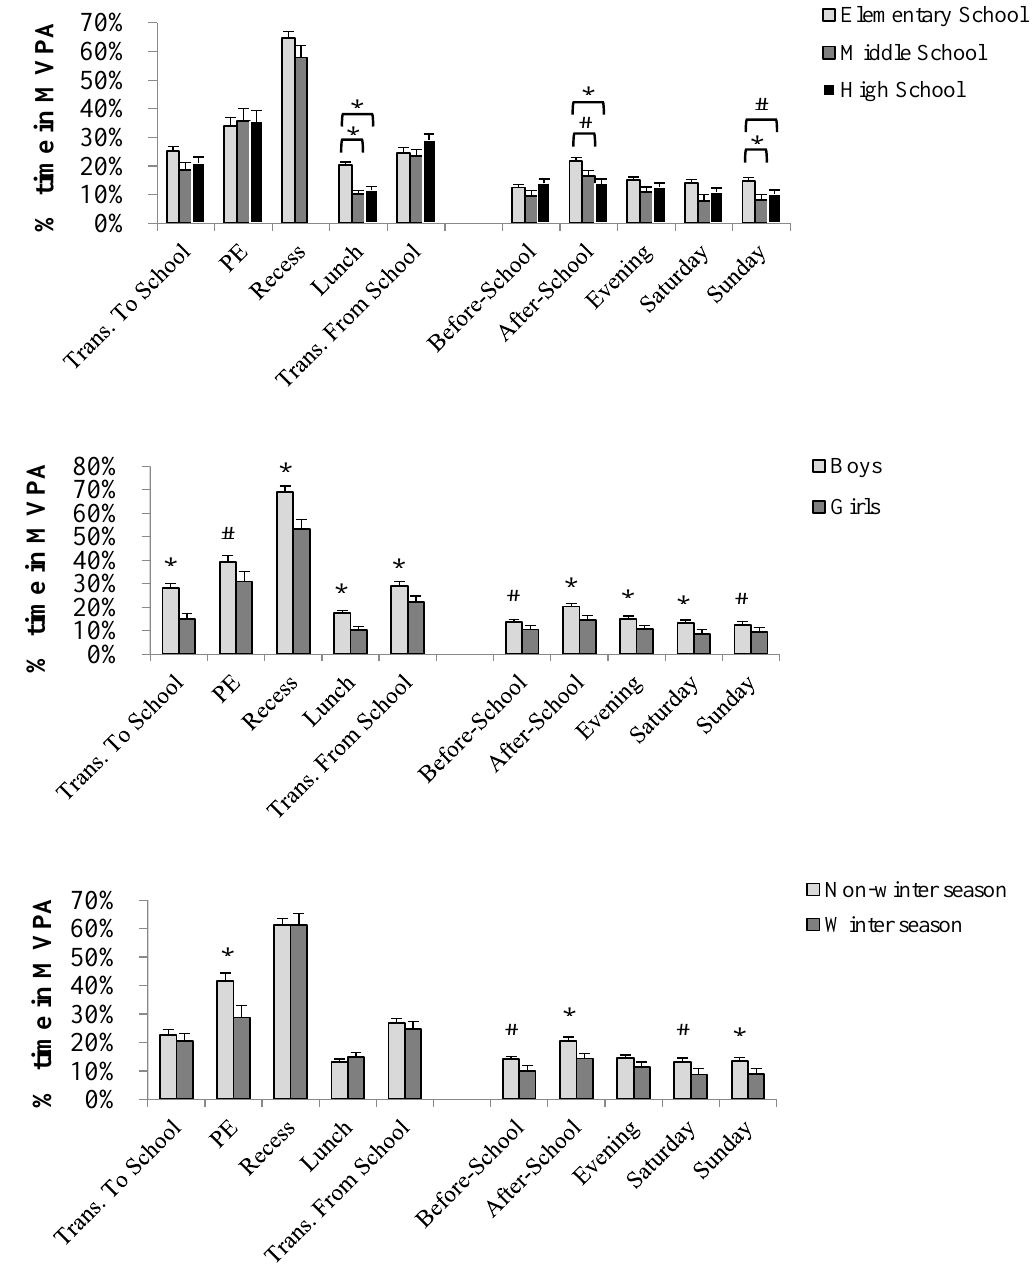
Figure 1. Week activity patterns by age group ( top ); sex ( middle ); and season ( bottom ). MVPA: moderate-to-vigorous physical activity. PE: physical education. * Indicates differences with p < 0.01. # Indicates differences with p < 0.05.